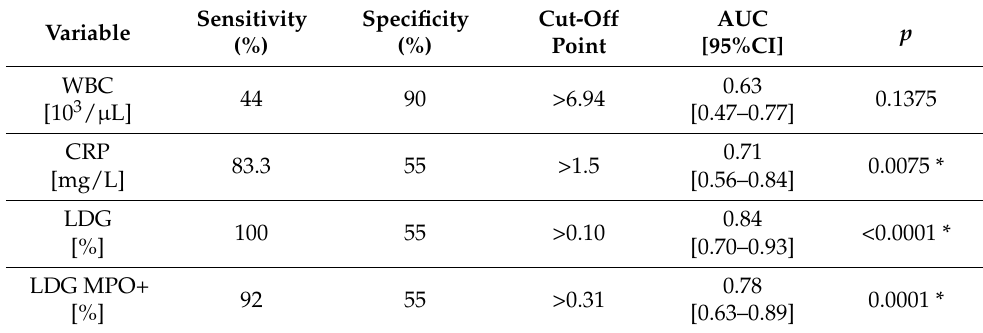
Table 2. Assessment of the diagnostic usefulness of selected inflammatory markers and the percentage of LDG, including the fraction showing MPO expression in the detection of AIH.